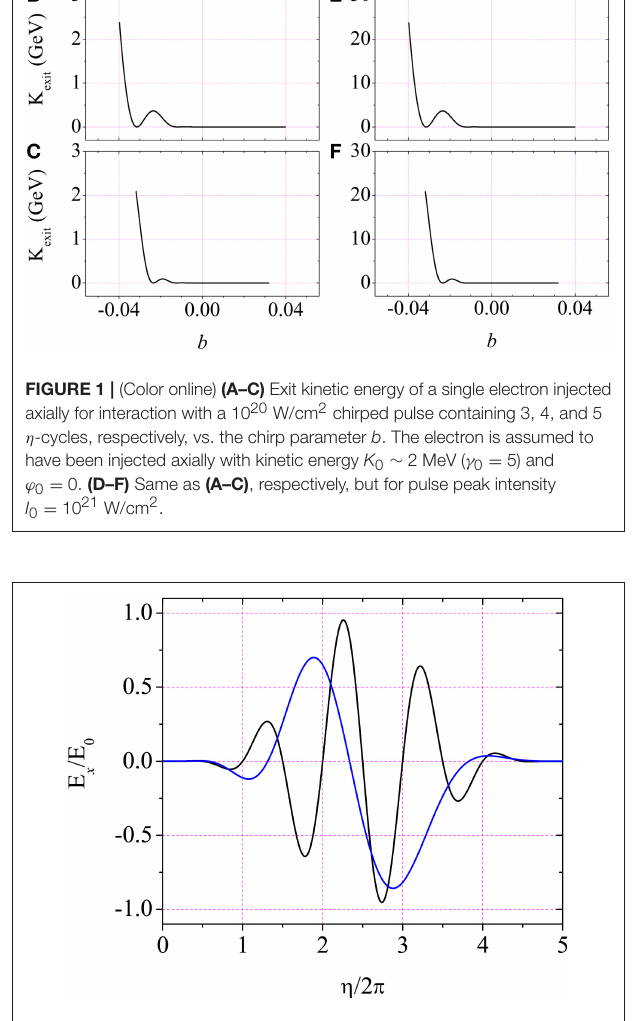
FIGURE 2 | (Color online) Scaled electric field, E x / E 0 , vs. the number of η − cycles for the un-chirped (black, b = 0) and chirped (blue, b = − 0.038) pulses. The graphs have been produced using λ = 1 µ m and ϕ 0 =